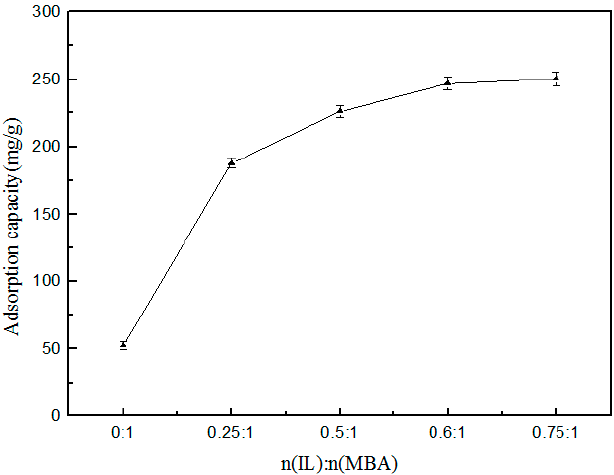
Figure 7. Effect of the amount of n(IL)/n(MBA). Figure 7. E ff ect of the amount of n(IL) / n(MBA).